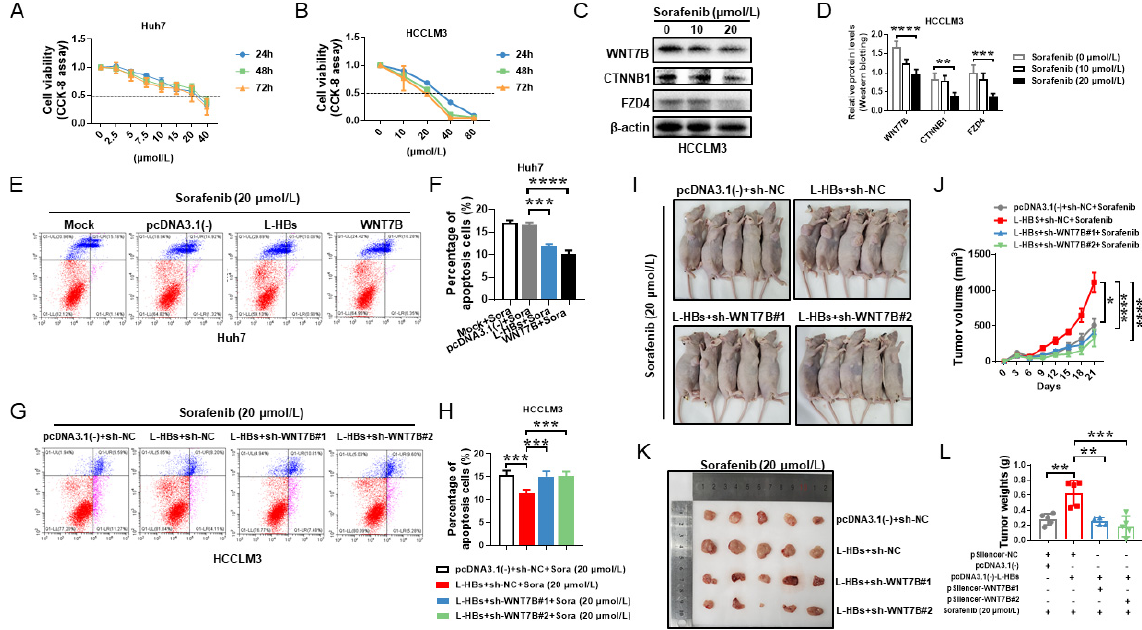
Figure 5. Sorafenib resistance is mediated by large hepatitis B surface antigens (L-HBs) via WNT7B. ( A , B ) In Huh7 and HCCLM3, cell viability was evaluated using the CCK-8 assay after treatment with a variety of sorafenib doses. ( C , D ) WNT7B, CTNNB1, and FZD4 expression were detected in HCCLM3 cells after sorafenib treatment by Western blotting. The levels of expression were quantified and given as mean ± SD of at least three independent experiments. ( E – H ) Flow cytometry was used to assess cell apoptosis rates using Annexin V-FITC/propidium iodide. A total of 10,000 cells were counted per sample for apoptosis analysis. The ratios of apoptotic cells are represented as the mean ± SD of four independent experiments. ( I , K ) The graph depicts the development of xenograft tumors in nude mice. ( J , L ) The graph shows the mean ± SEM of tumor volume ( I ) and the mean ± SD of tumor weight ( L ) induced by indicated plasmids-transfected HCCLM3 cells of five independ- ent experiments. * p < 0.05, ** p < 0.005, *** p < 0.001, **** p < 0.0001. WNT7B, FZD4, and CTNNB1 protein levels were considerably decreased in HCCLM3 cells treated with sorafenib in a concentration-dependent manner when com- pared to DMSO-treated cells, as shown in Figure 5C,D. Flow cytometry revealed that L- HBs or WNT7B reduced the cytotoxicity of sorafenib (20 μ mol/L) by approximately 28.3% and 39.6%, respectively, compared to the negative control (Figure 5E,F, p < 0.001). The findings suggest that L-HBs and WNT7B might both protect HCC cells from sorafenib- induced cell death. Flow cytometry and xenograft in nude mice were used to assess whether L-HBs in- duced sorafenib resistance via WNT7B in HCC cells. Flow cytometry revealed that knock- ing down WNT7B expression restored L-HBs protection against sorafenib-induced apop- tosis by approximately 1.3-fold ( p < 0.001; Figure 5G,H). Overexpression of L-HBs in so- rafenib-treated HCCLM3 cells increased xenograft sizes and weights compared to the neg- ative control in the xenograft model. However, knocking down WNT7B in sorafenib- treated HCCLM3 cells drastically decreased tumor sizes and weights, which were boosted by L-HBs (Figure 5I–L). These findings imply that L-HBs mediate sorafenib resistance via WNT7B.